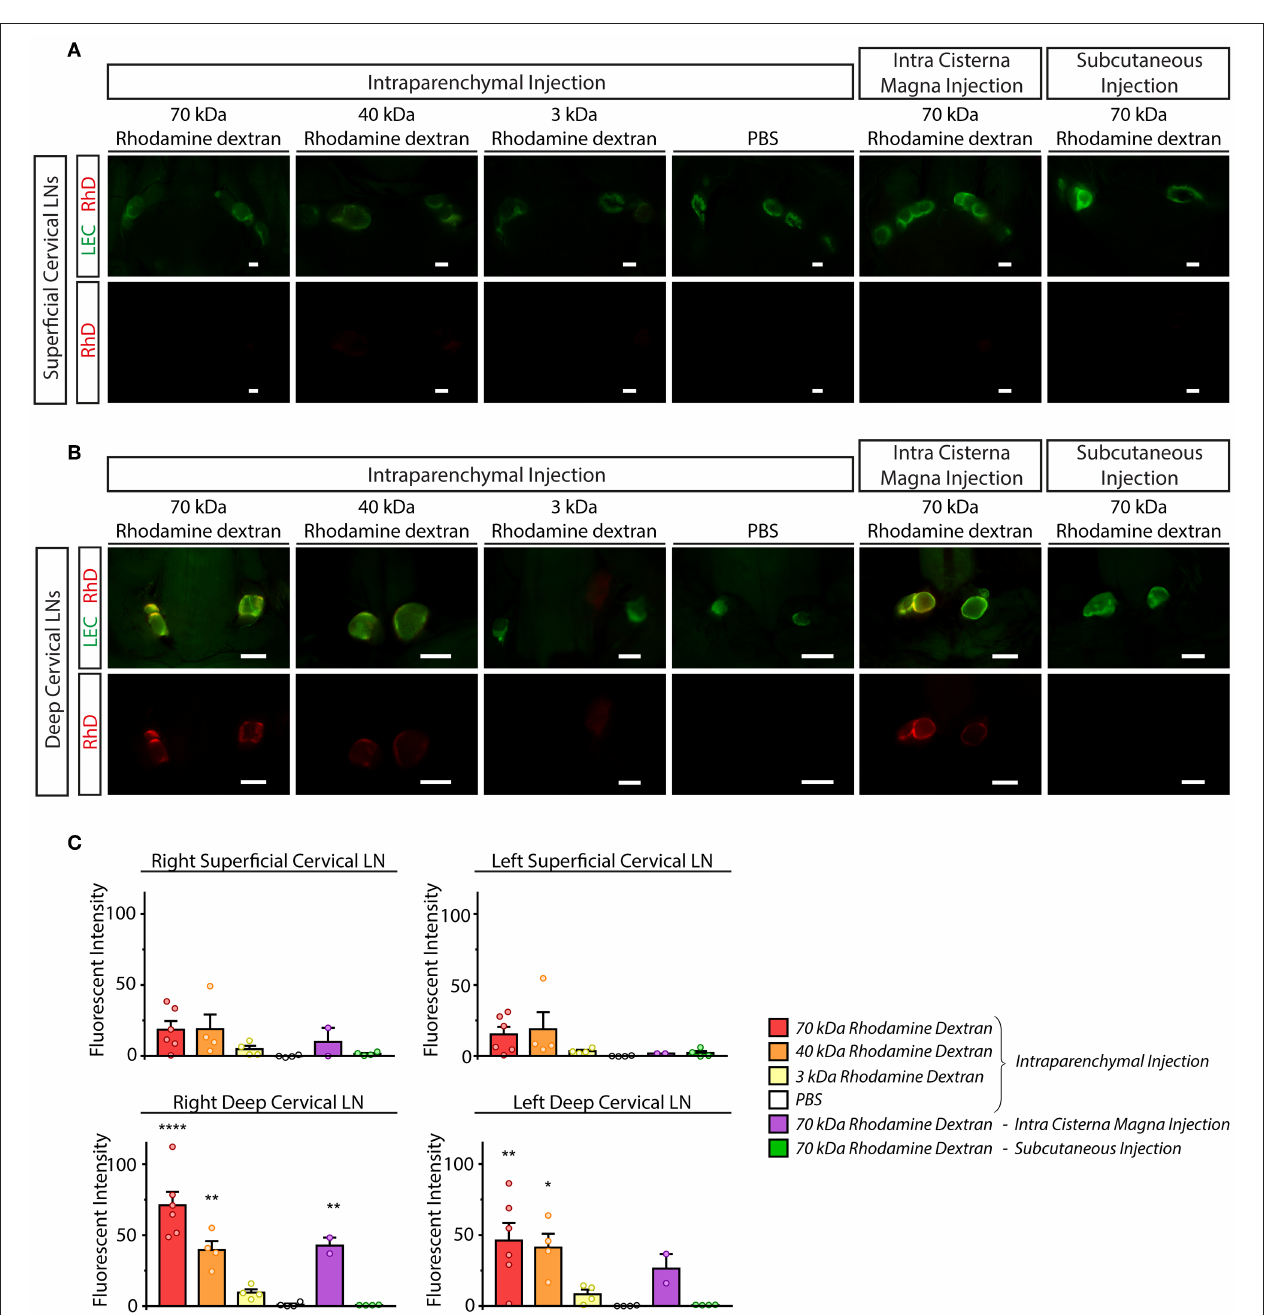
FIGURE 4 | Monitoring the drainage of macromolecules from the CNS to the superficial and deep cervical lymph nodes. (A,B) Accumulation of the injected labeled macromolecules in the superficial cervical lymph nodes (A) and deep cervical lymph nodes (B) of lymphatic reporter mice after intraparenchymal injection of 70, 40 and 3 kDa RhD, PBS, intra cisterna magna injection of 70 kDa RhD and subcutaneous injection of 70 kDa RhD at the same injection site which was used for the intraparenchymal injections ( n = 6 for 70 kDa RhD intraparenchymal injection; n = 4 for 40 kDa RhD intraparenchymal injection; n = 4 for 3 kDa RhD intraparenchymal injection; n = 4 for PBS intraparenchymal injection; n = 2 for 70 kDa intra cisterna magna injection; n = 4 for 70 kDa RhD subcutaneous injection). Bars, 1,000 µ m. Representative images are shown. (C) Quantitative data are shown for mean fluorescent intensity in the lymph nodes of the cervical region (mean fluorescent intensity of background subtracted from the mean fluorescent intensity of lymph nodes) compared to PBS injection (One-way ANOVA, Dunnett’s post-hoc test; mean ± SEM; n = 3 or more animals for each group; n = 6 for 70 kDa RhD intraparenchymal injection; n = 4 for 40 kDa RhD intraparenchymal injection; n = 4 for 3 kDa RhD intraparenchymal injection; n = 4 for PBS intraparenchymal injection; n = 2 for 70 kDa intra cisterna magna injection n = 4 for 70 kDa RhD subcutaneous injection; * P < 0.05 vs. intraparenchymal PBS injection; ** P < 0.01 vs. intraparenchymal PBS injection; **** P < 0.0001 vs. intraparenchymal PBS injection).